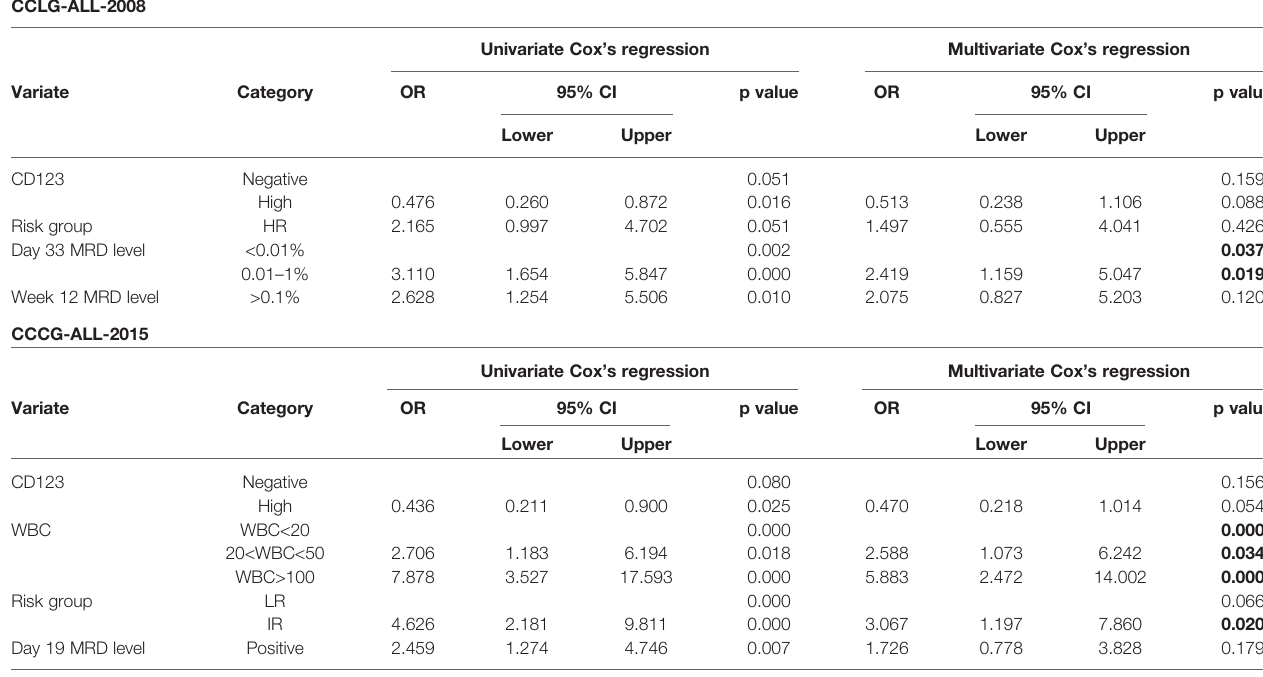
Univariate Cox ’ s regression Multivariate Cox ’ s regression